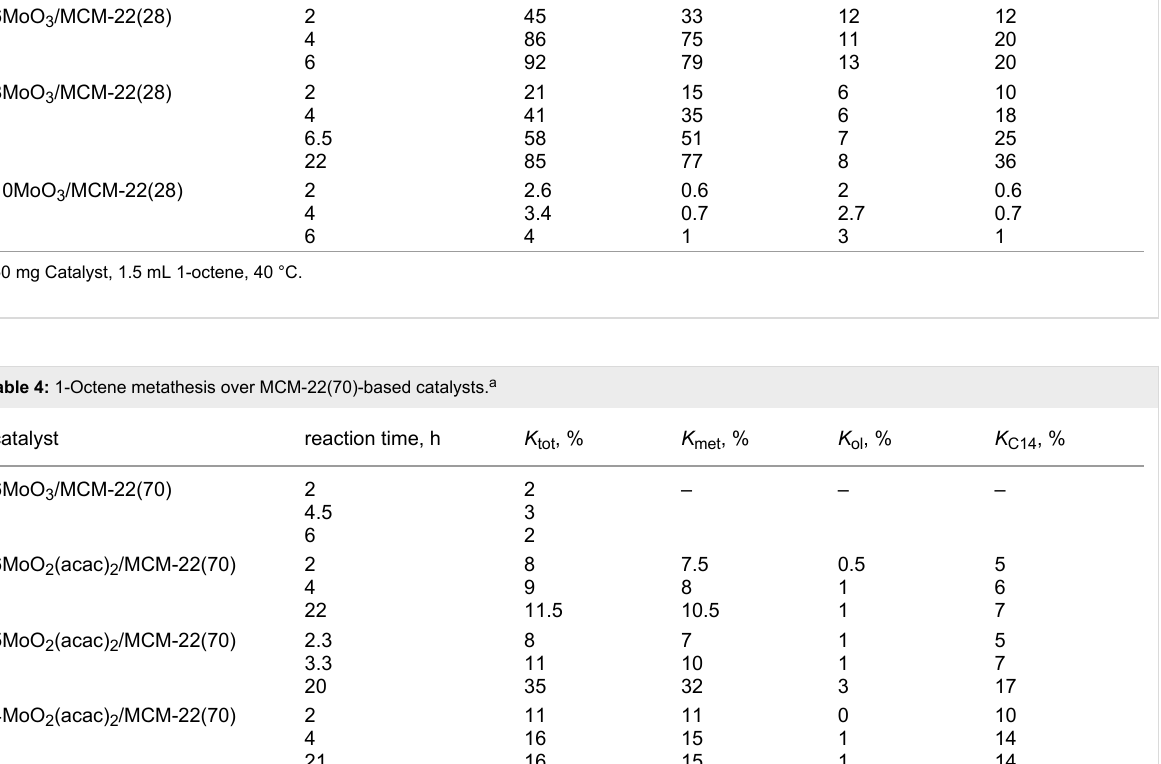
6MoO 3 /MCM-22(28)